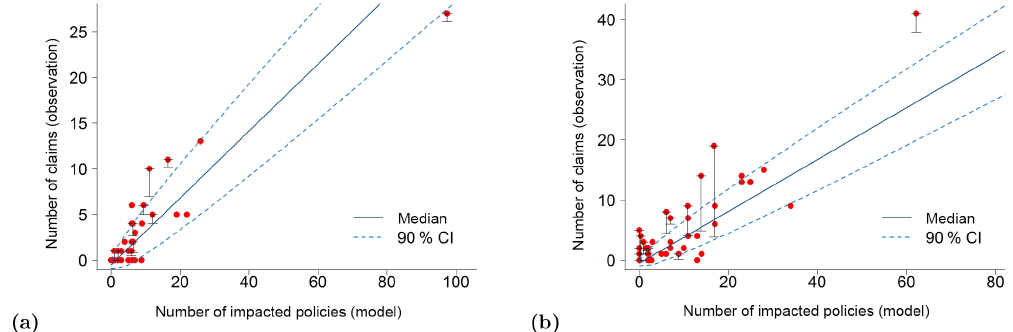
Figure 8. Comparison of estimated number policies affected by the flood (model), and associated number of claims for each river reach: (a) Alès 2002 event and (b) Draguignan 2010 event. Blue lines correspond to the mean claims / policies binomial relationship and associated 90% confidence interval, vertical bars represent uncertainty in the number of claims related to river